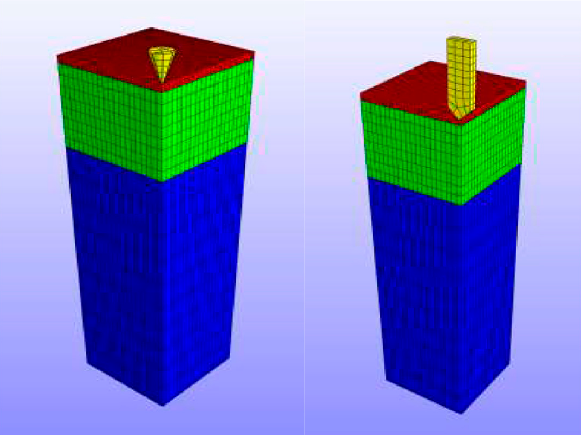
Figure 12. A numerical mesh used for finite element method (FEM) modelling of MN design (adopted from [90]).